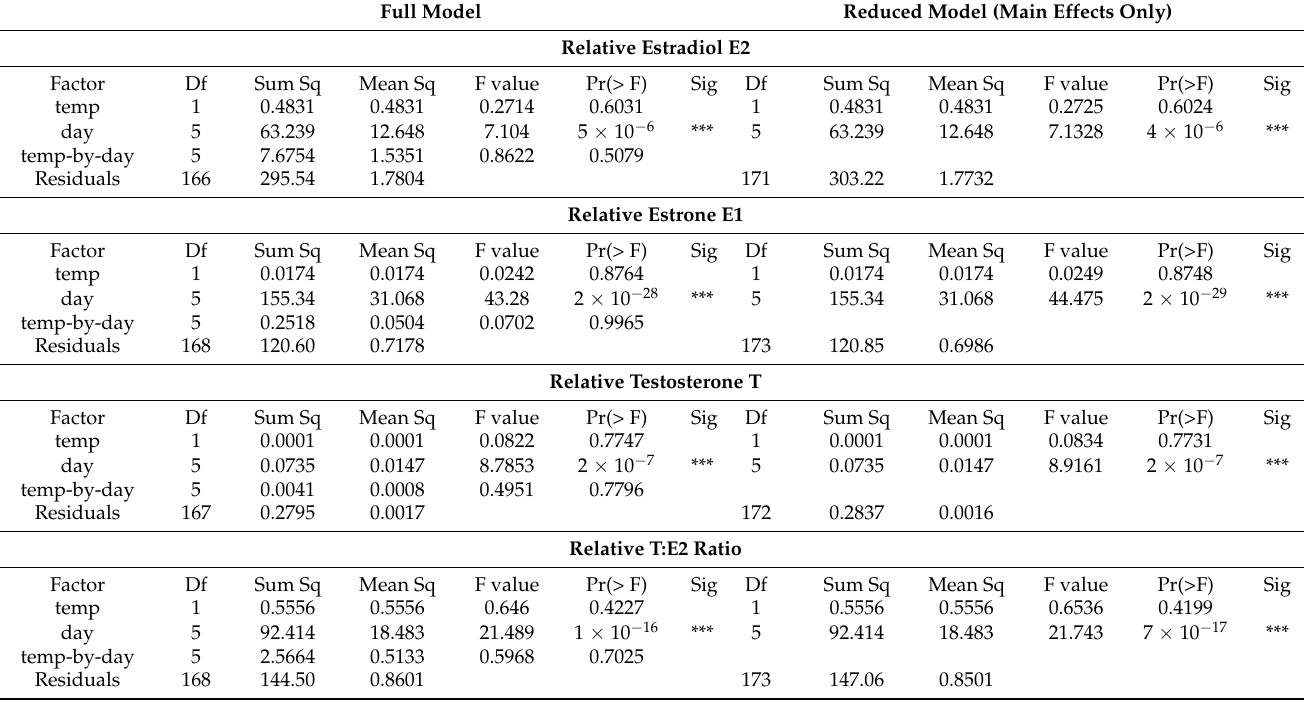
Table 2. Results from the ANOVA tests using Box–Cox-transformed corrected (relative) hormone values (i.e., raw values multiplied by dilution factor), after outliers were removed (see text for details). Full Model Reduced Model (Main Effects